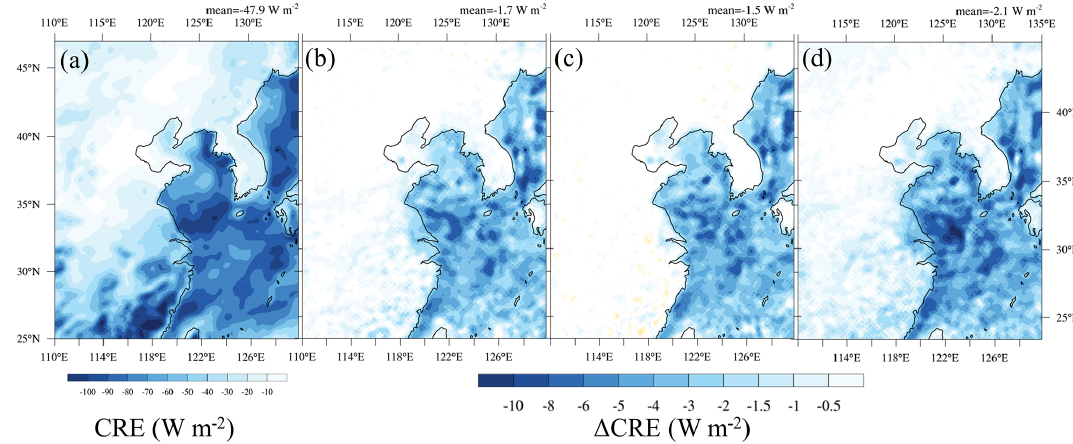
Figure 7. The simulated 30d averaged (00:00UTC on 16 May to 00:00UTC on 15 June 2016) cloud radiative effect (CRE) for (a) AS and the differences ( (cid:49) CRE) between (b) RA and AS, (c) LO and AS, and (d) SA and